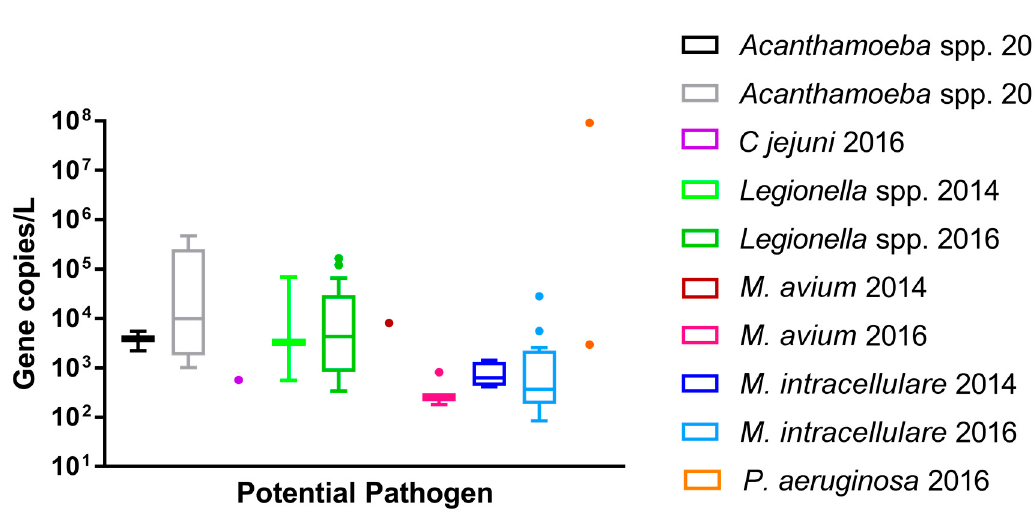
Figure 2. Potential pathogen concentrations measured in positive samples from 2014 and 2016 sampling. Parameters of box plot shown are 25th, 50th, and 75th percentiles with whiskers extending to 5th and 95th percentiles for datasets with more than three observations. Data with fewer than 3 positive detections are shown as points.